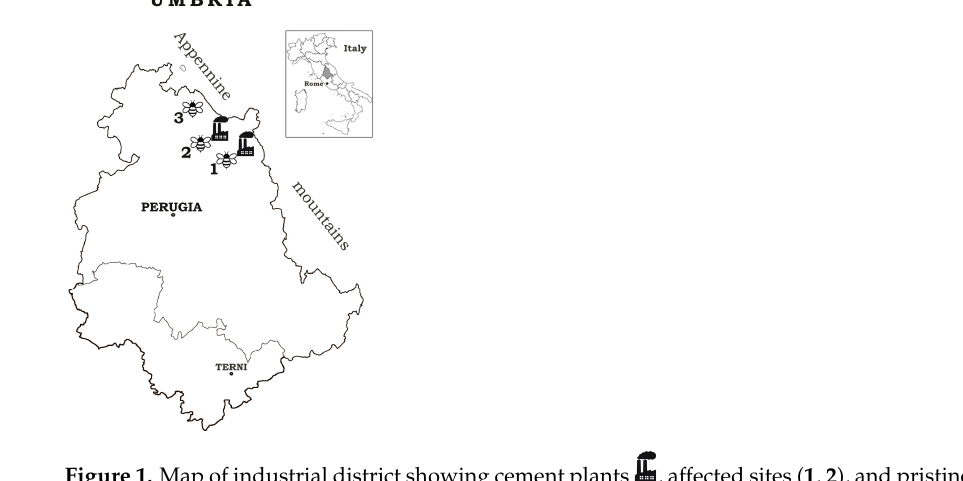
Figure 1. Map of industrial district showing cement plants , affected sites ( 1 , 2 ), and pristine area .